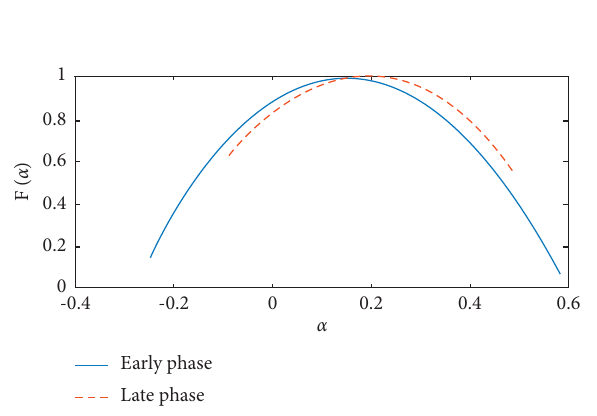
Figure 27: Multifractal